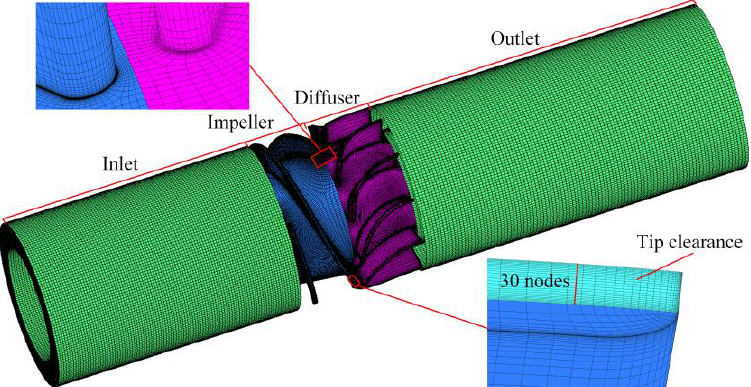
Figure 2. Grid of the computational domain.